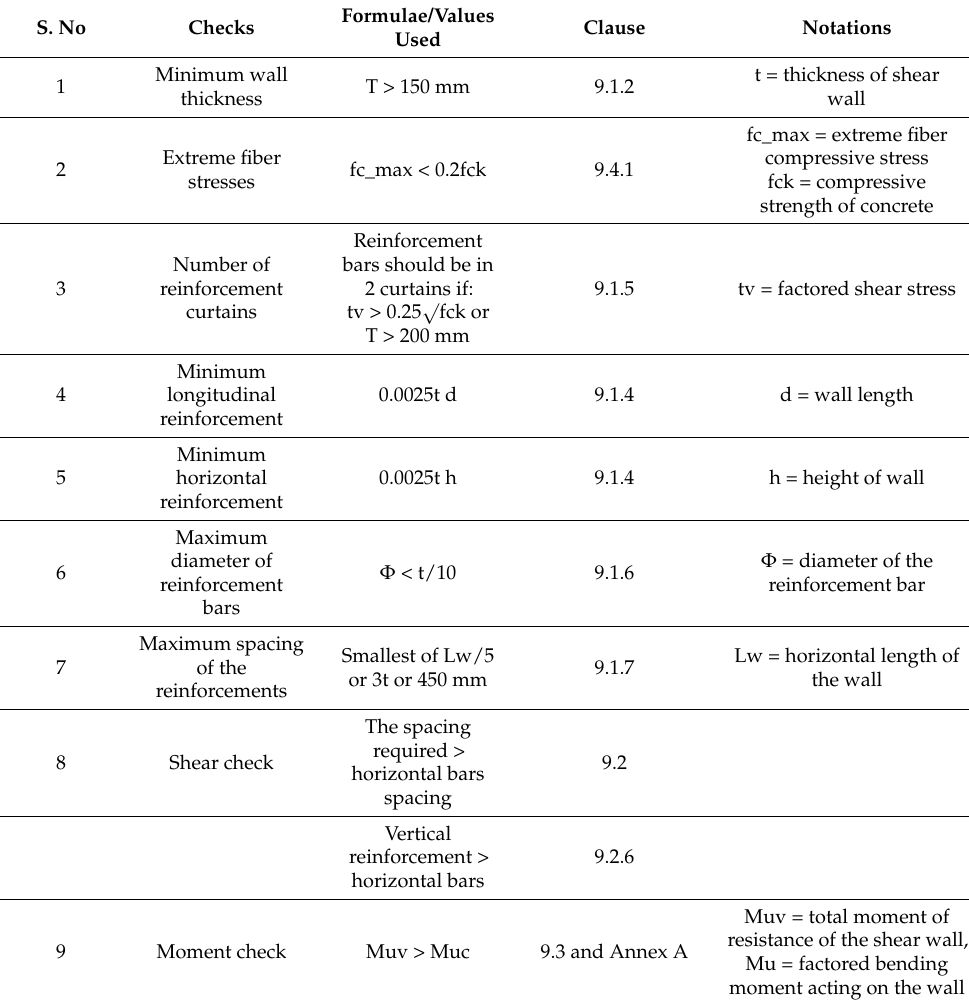
Table 3. Code Checks for The Shear Wall as Per IS 13920.